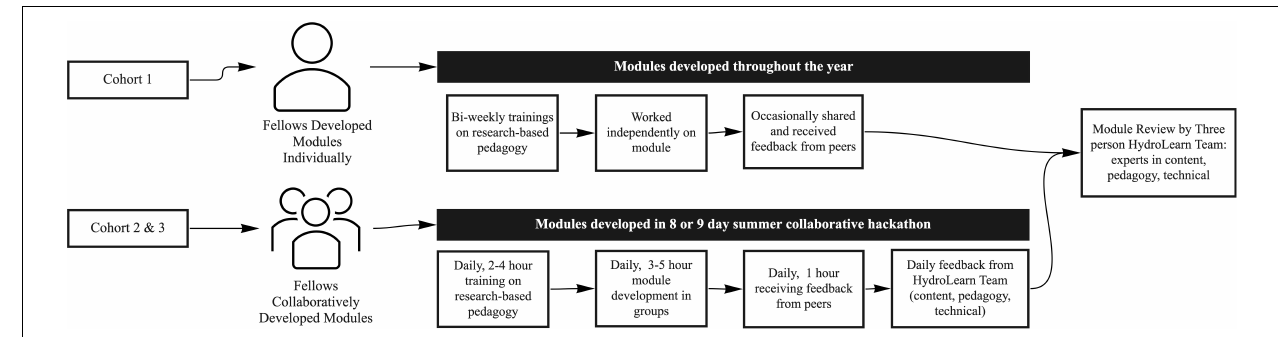
FIGURE 2 | Two approaches to professional learning used to develop HydroLearn